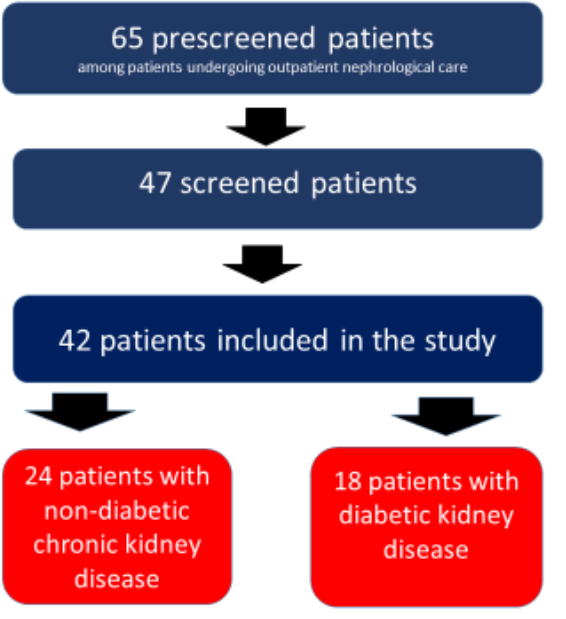
Figure 1. Flowchart of patients.